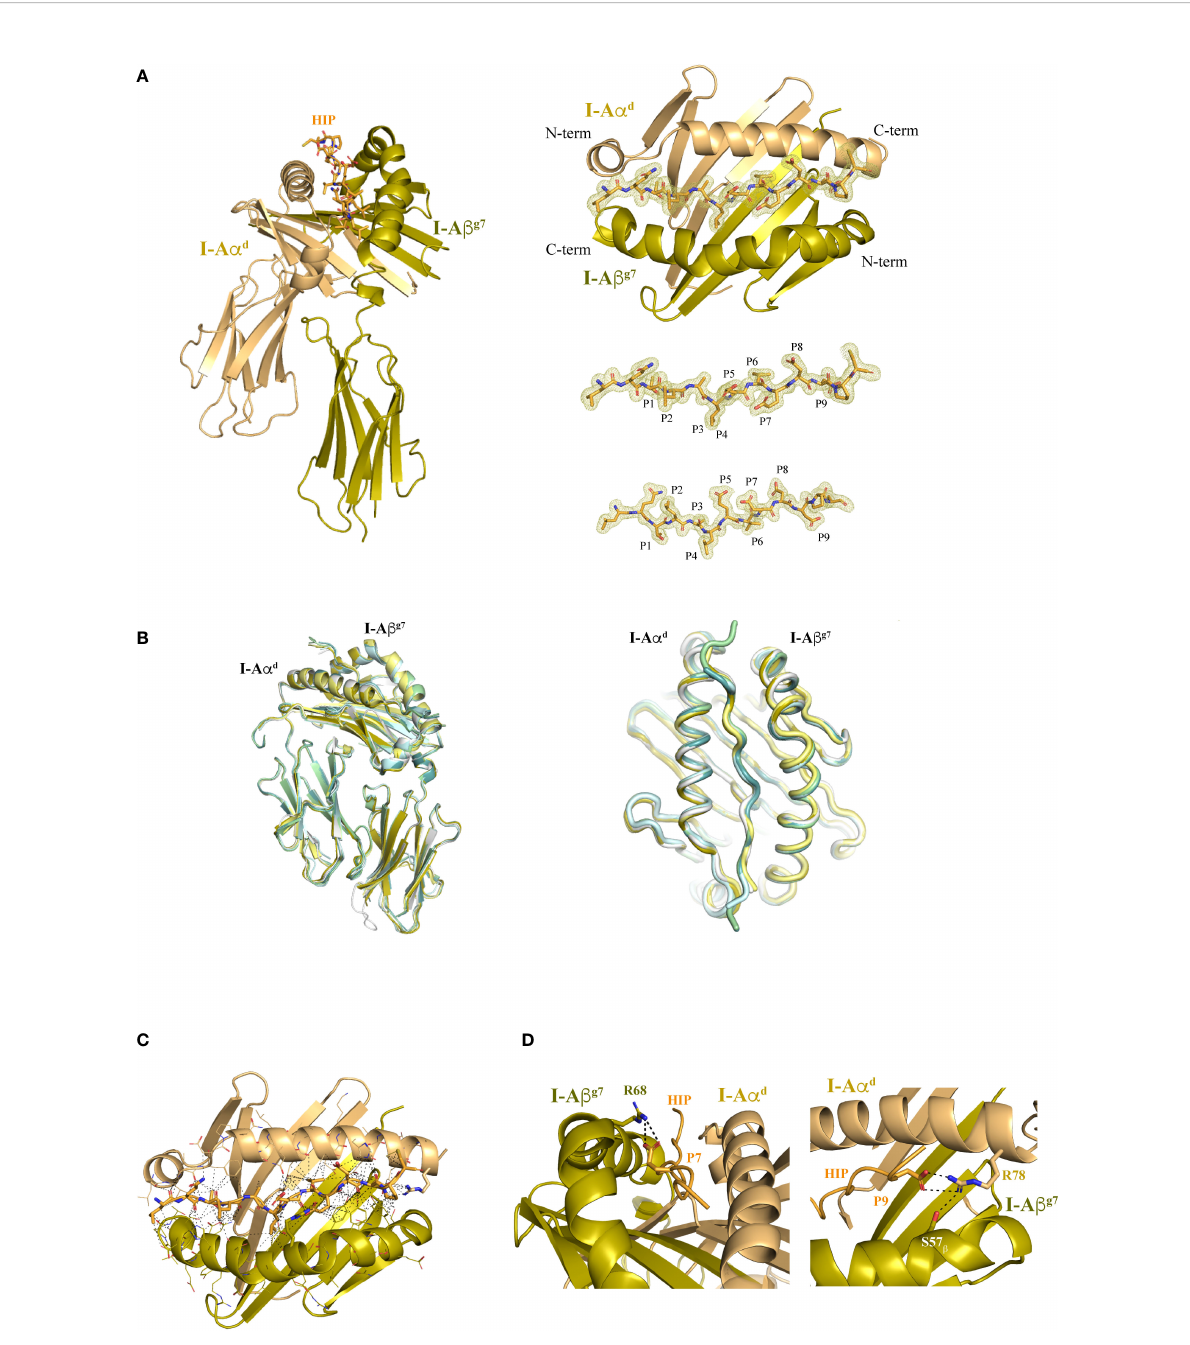
FIGURE 2 Structure of I-A g7 with a bound agonistic hybrid insulin peptide (HIP39). (A) Left panel, I-A a d and I-A b g7 chains are shown in dun and olive colors, respectively, with the bound HIP39 peptide shown in stick format in the central cavity. Right top panel, top view of the I-A g7 MHC platform and the HIP antigen inside the 2Fo-Fc map, shown as a light yellow colored mesh. Right lower panel, top and side views of the HIP antigen surrounded by the 2Fo-Fc map. (B) Lateral and top views of HIP39/I-A g7 overlayed with other I-A g7 complexes crystallized with their respective peptides (HIP, gray, PDB 7QHP; pale yellow, GAD65, PDB 1ES0; RLGL-WE14, olive, PDB 5DMK; p8E9E, pale green, PDB 6BLQ; p8E9E6SS, pale cyan, PDB 6BLR; p8G9E, light teal, PDB 6BLX). (C) The contacts ( ≤ 4 Å) between I-A g7 and the HIP are displayed as dashed lines. (D) Detail of the salt bridge formed between I-A b g7 Arg68 and Glu (P7) in the HIP and between I-A a d Arg78 with Asp (P9). The H-bond of Arg78 with I-A b g7 Ser57 is also